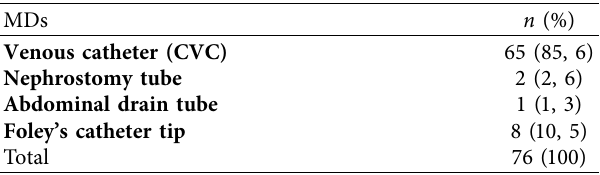
Table 1: Medical devices